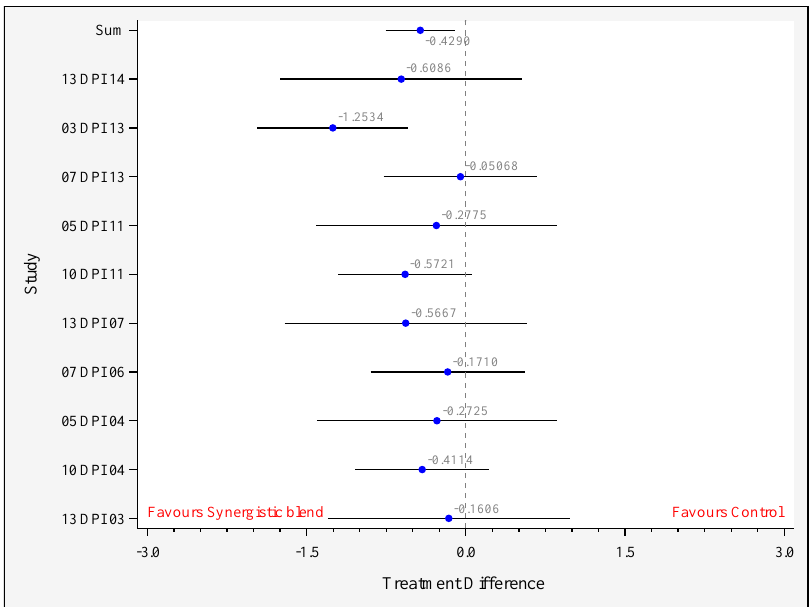
Table 2. Meta-analysis of cecal Salmonella counts.